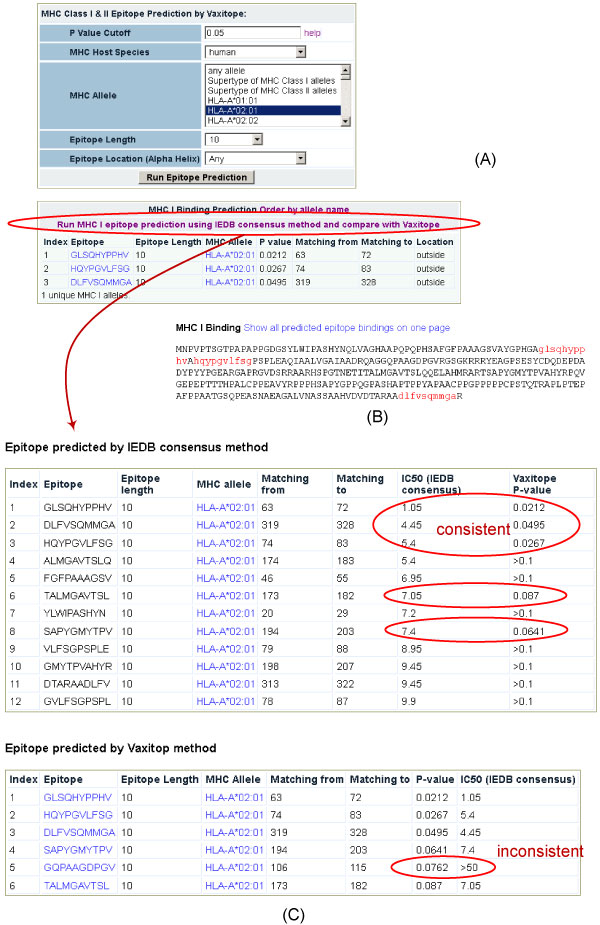
Vaxign prediction of MHC Class I HLA-A*0201 immune epitopes of HSV-1 UL26.5 capsid scaffold protein using Vaxign-Vaxitop program and IEDE prediction program. (A) Selection of parameters for epitope prediction. (B) Display of the locations of all predicted epitopes in the whole length protein. (3) Comparison of predicted results between Vaxitop and IEDB program. The label "consistent" means that the circled results were predicted by both programs. The label "inconsistent" indicates that the circled result was predicted to be positive by Vaxitop but not by IEDB program.